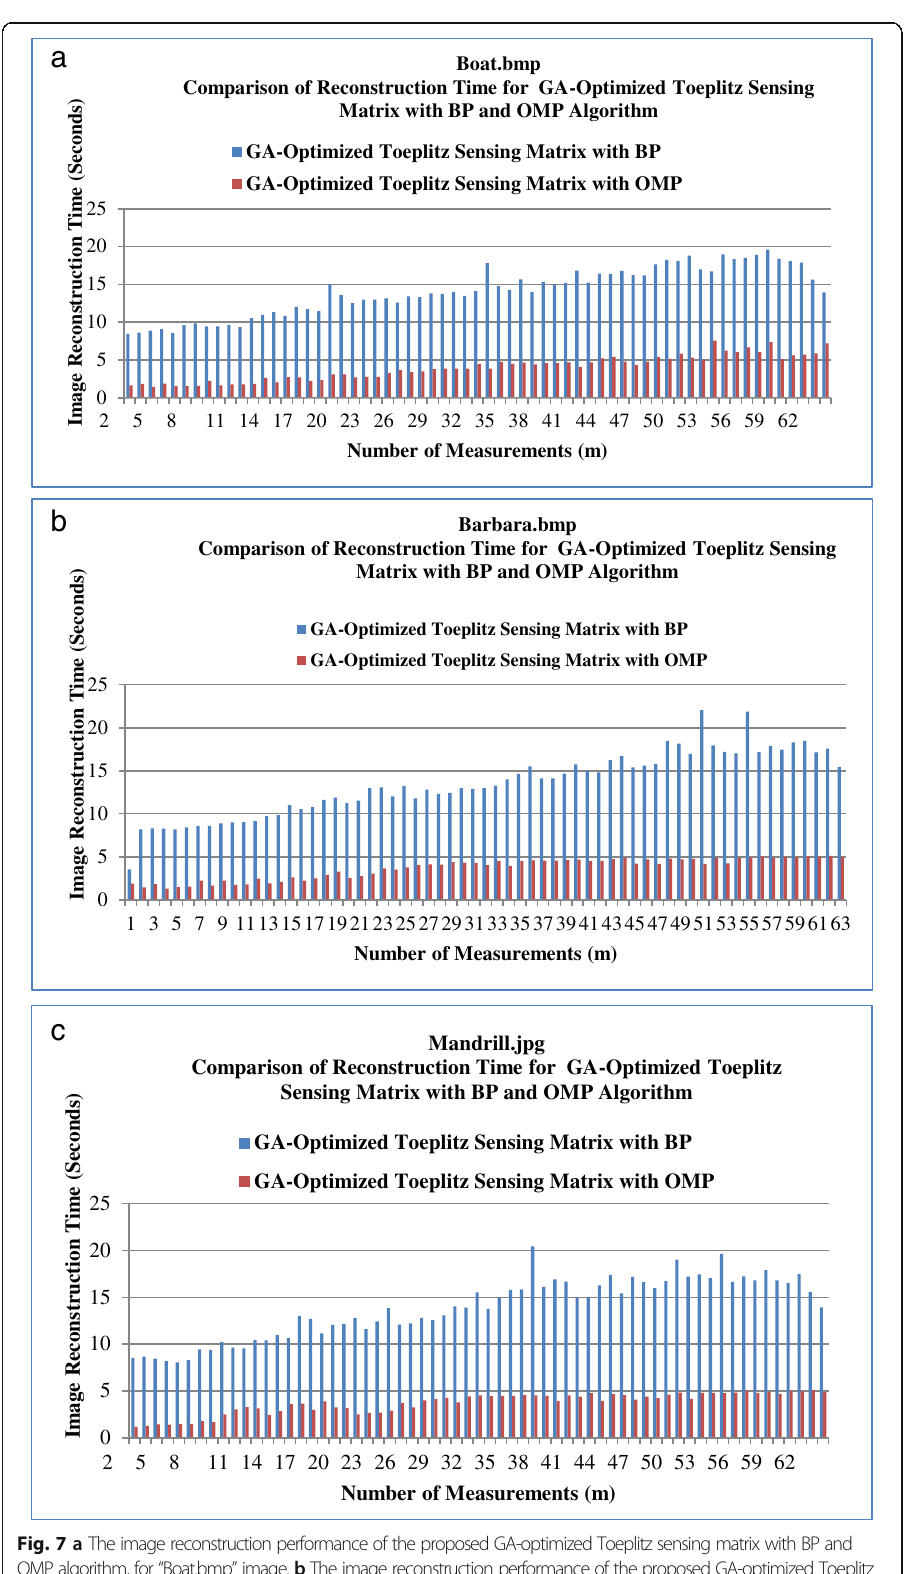
Fig. 7 a The image reconstruction performance of the proposed GA-optimized Toeplitz sensing matrix with BP and OMP algorithm, for “ Boat.bmp ” image. b The image reconstruction performance of the proposed GA-optimized Toeplitz sensing matrix with BP and OMP algorithm, for “ Barbara.bmp ” image. c The image reconstruction performance of the proposed GA-optimized Toeplitz sensing matrix with BP and OMP algorithm, for “ Mandrill.jpg ”